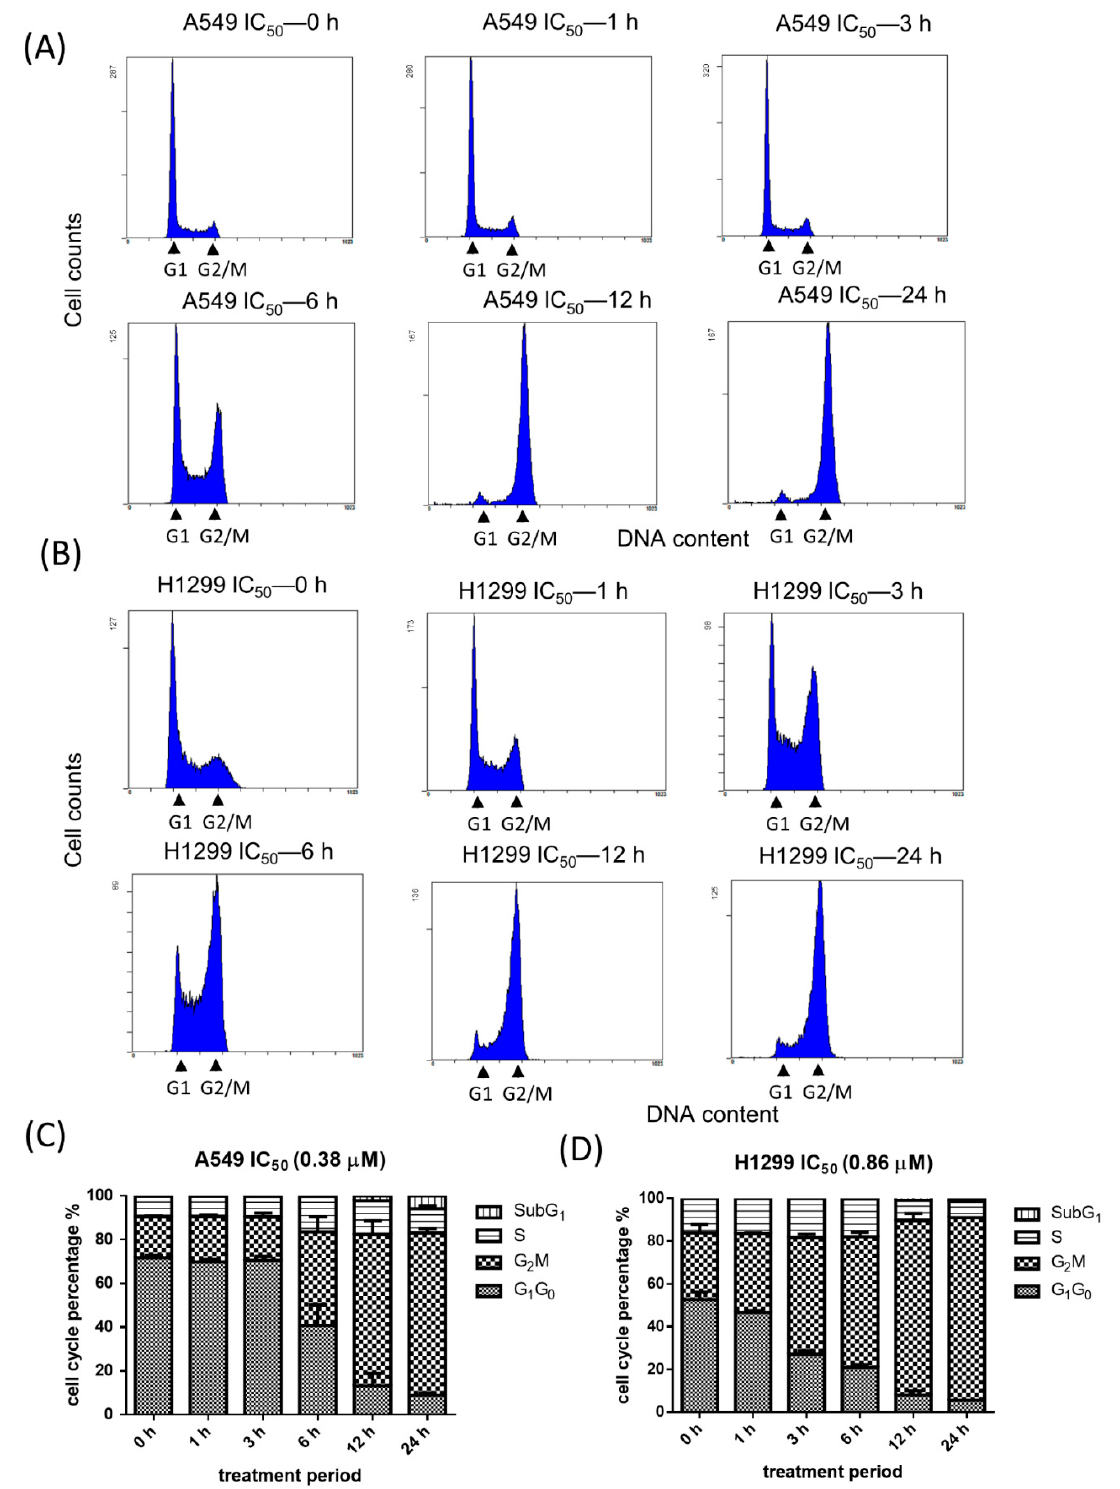
Figure 2. Analysis of cell cycle distribution by flow cytometry after NSCLC cells were treated with BPR0C261. ( A ) A549 cells and ( B ) H1299 cells were treated with their corresponding IC 50 of BPR0C261 with a time-dependent cell cycle redistribution. ( C , D ) Quantification of percentage of each cell cycle phase in A549 cells and H1299 cells, respectively. Each datum represents the mean of three independent experiments ± S.D.